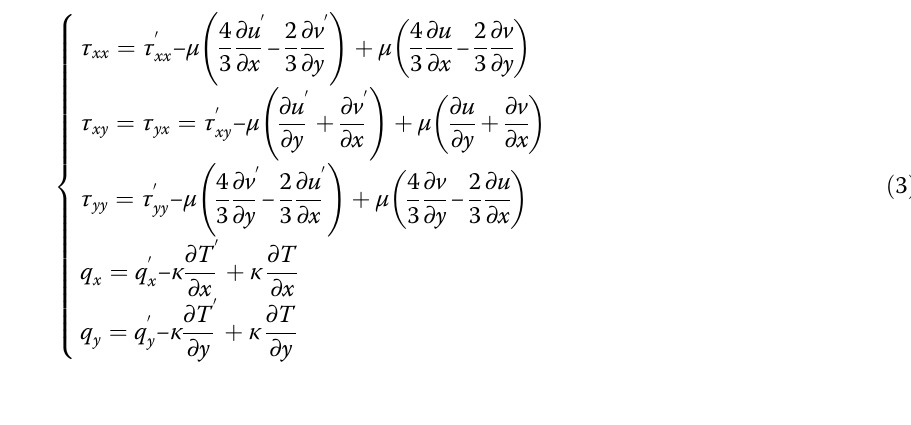
Table 1 Flow features used as input in the regression for DNCR Feature Description Kn GLL ( ρ ) Local Knudsen numbers of density